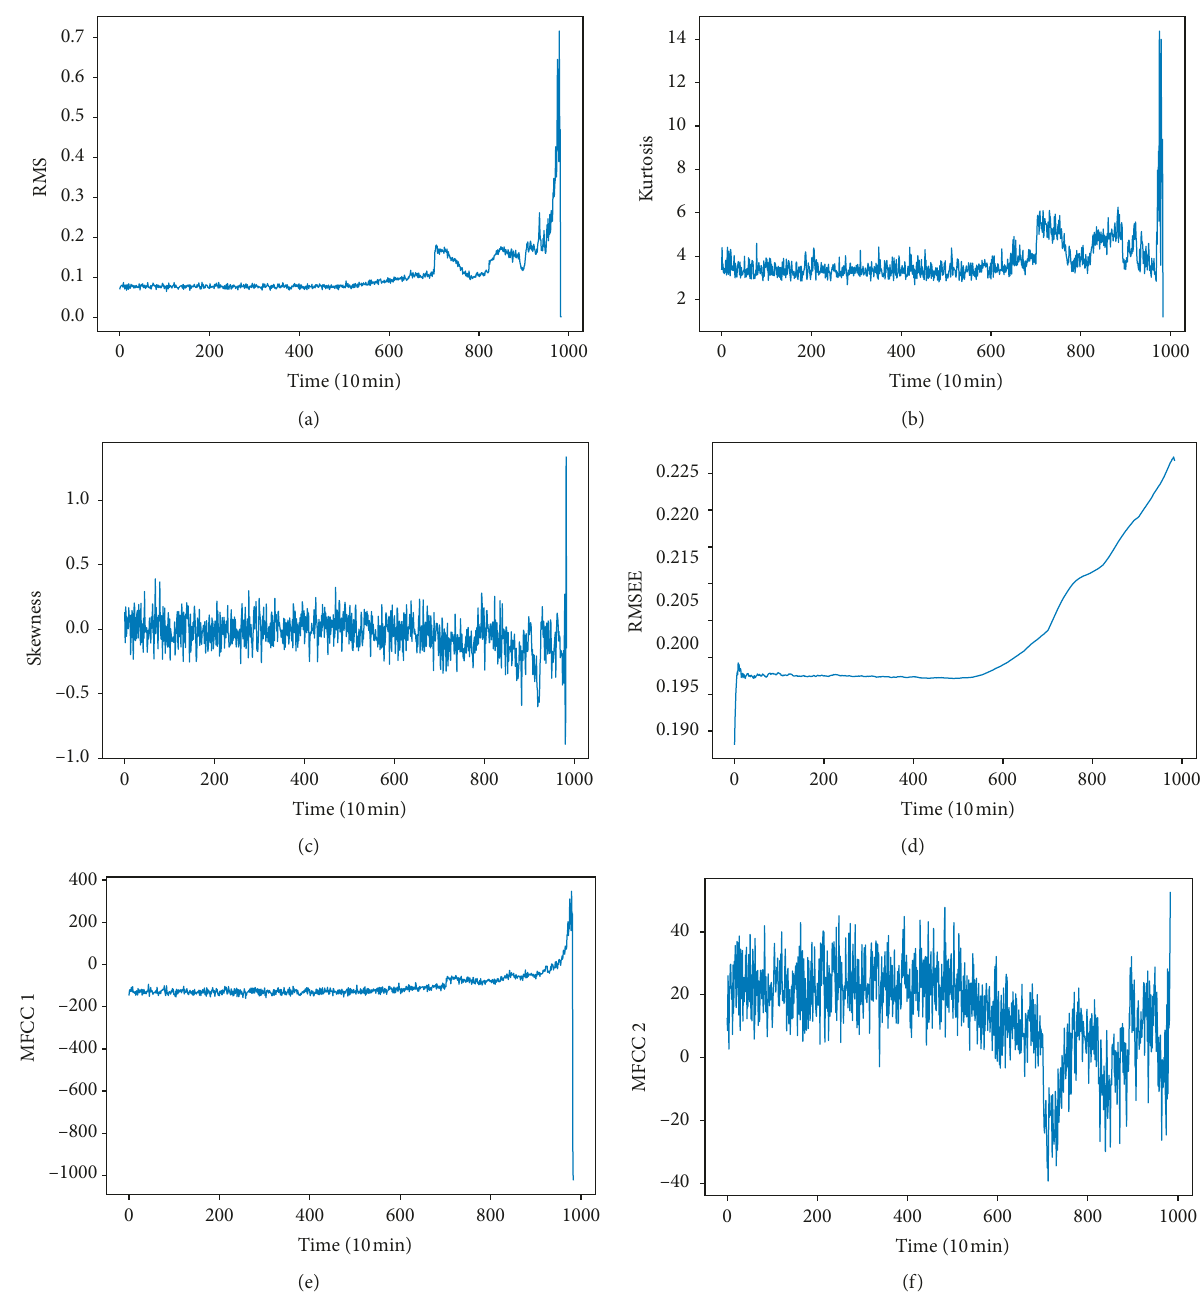
Figure 6: Time-domain